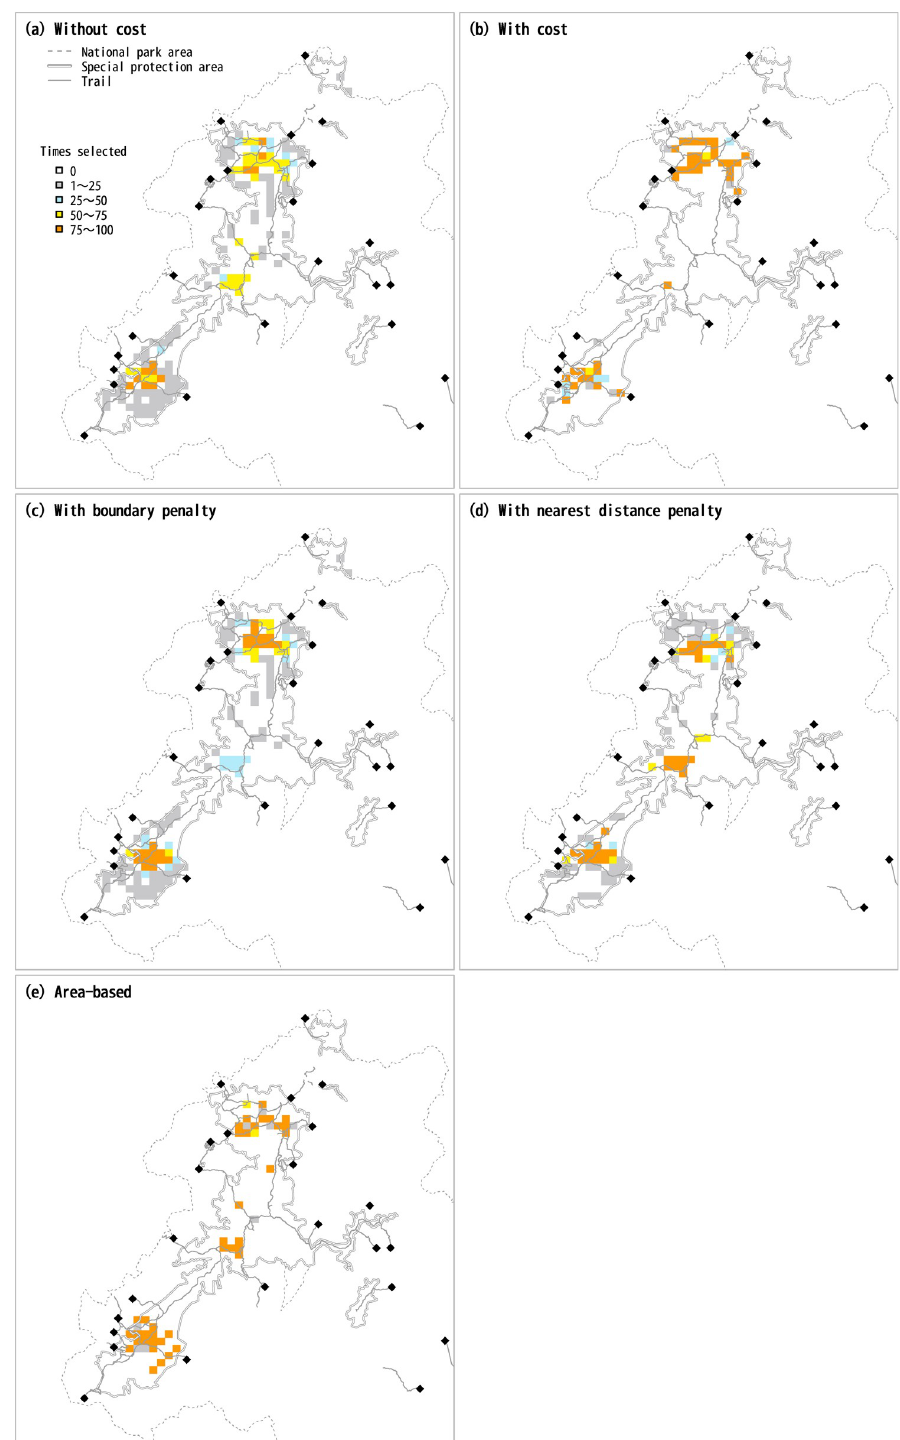
Fig 5. Comparison of site selection results with different SecSel parameter settings. The national park area was drawn based on information provided by the Ministry of Land, Infrastructure, Transport and Tourism [14], and the trails were drawn based on information provided by the Ministory of the Environment [15] under a CC BY license with permission.